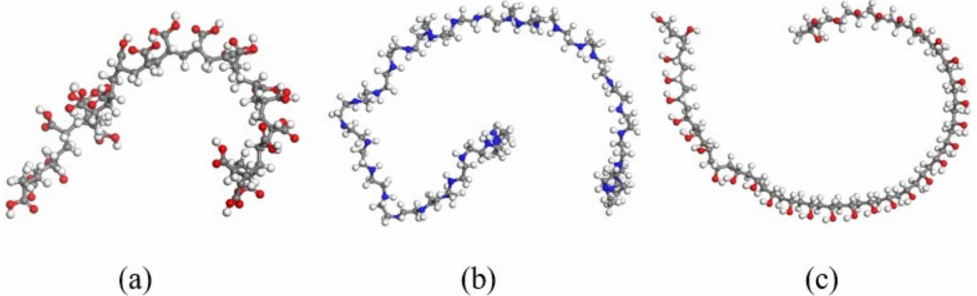
Figure 6. Additive conformations. ( a ) PAA, ( b ) PEI, and ( c )